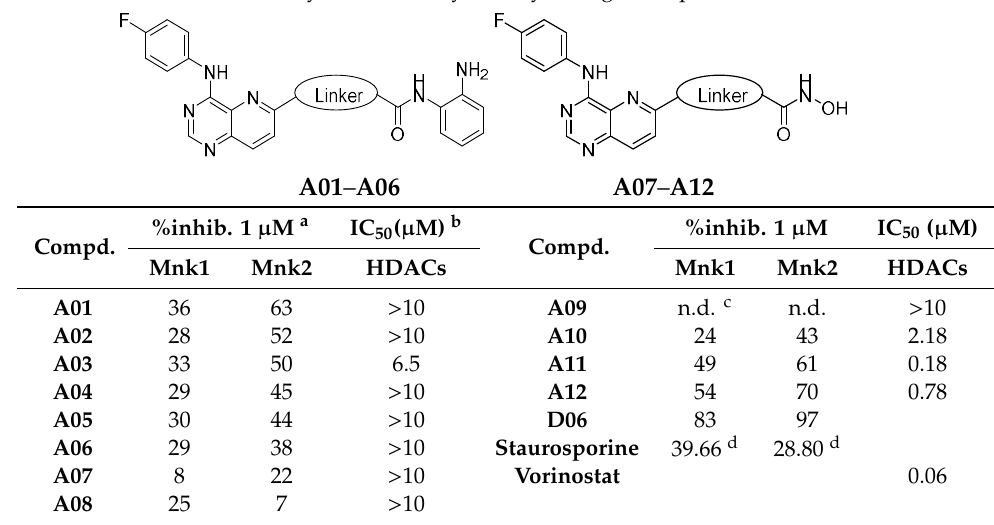
Table 1. In vitro enzymes inhibitory activity of target compounds A01 – A12 .